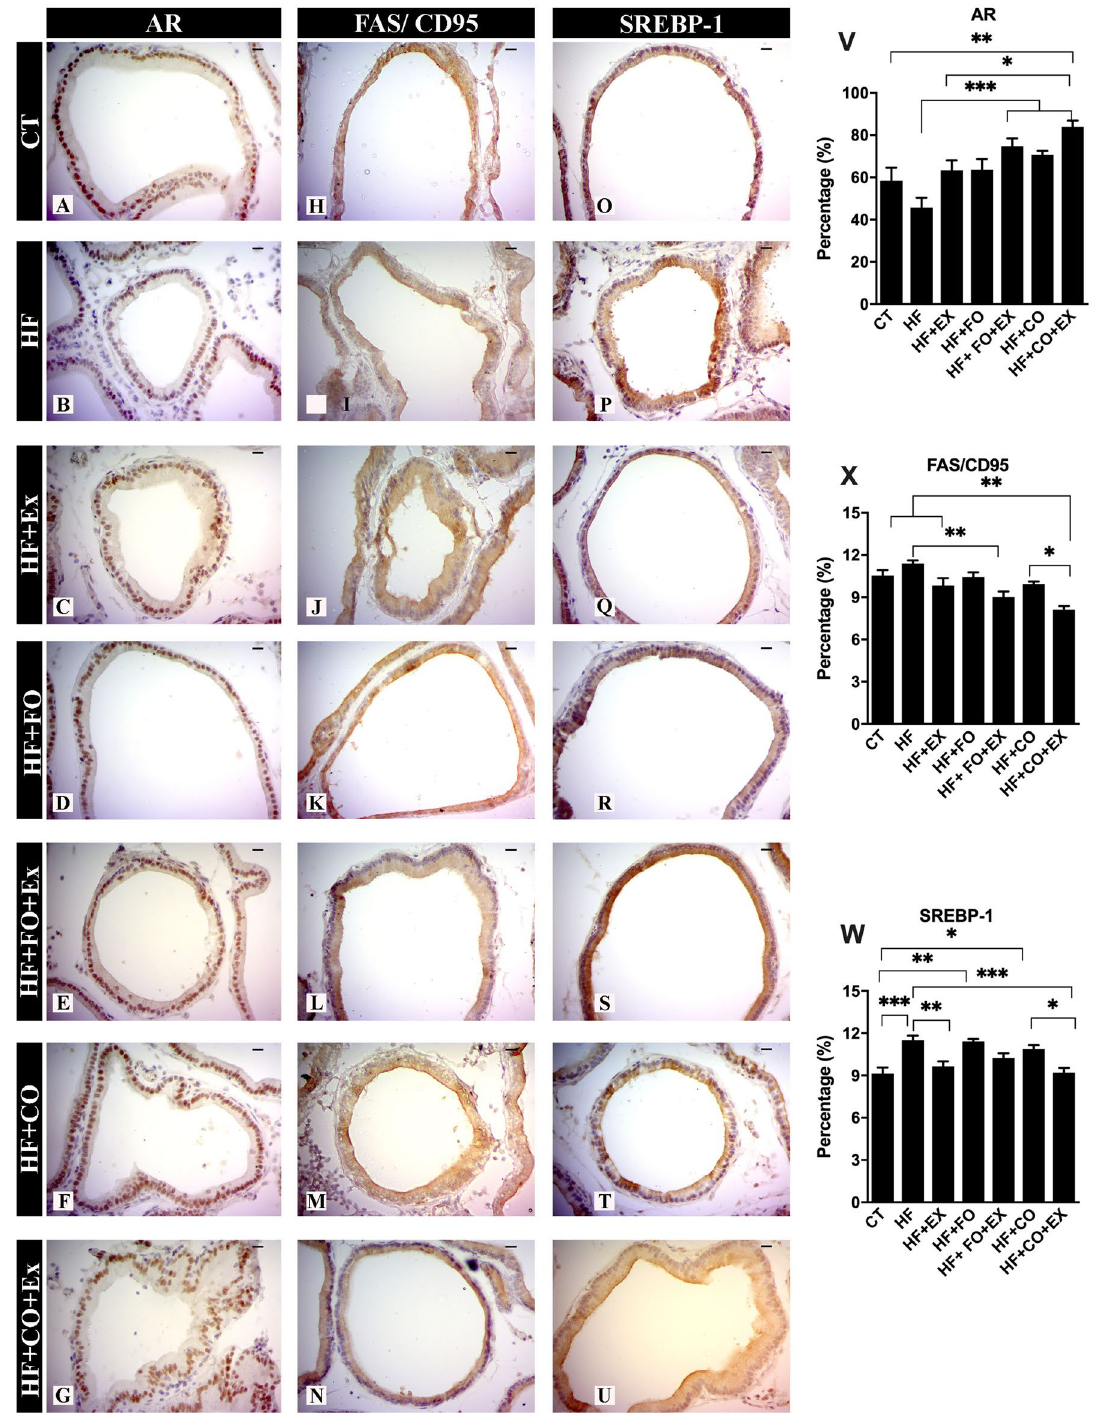
Figure 4. The data are presented as the mean ± SEM (n = 7). The significance of p < 0.05 is indicated by * and p > 0.05 ** indicating a difference between the groups. ( A ) CT—control; ( B ) HF—high-fat diet; ( C ) HF + Ex— high fat and aerobic exercise; ( D ) HF + FO—high fat and fish oil; ( E ) HF + FO + Ex—high fat, fish oil and aerobic exercise; ( F ) HF + CO—high fat and chia oil; ( G ) HF + CO + Ex—high fat, chia oil and aerobic exercise. Graph I: androgen receptor expression (AR); Graph II: death receptor expression (FAS/CD95); Graph III: Sterol regulatory element-binding transcription factor-1 (SREBP-1). The Two-Way ANOVA test was used to compare the means, with the Tukey post-test. Bar = 20 µm; Resolution =